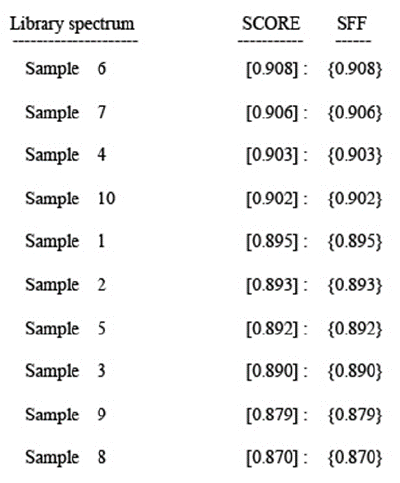
Figure 8. Results of the Spectral Analyst algorithm using Spectral Feature Fitting (SFF)